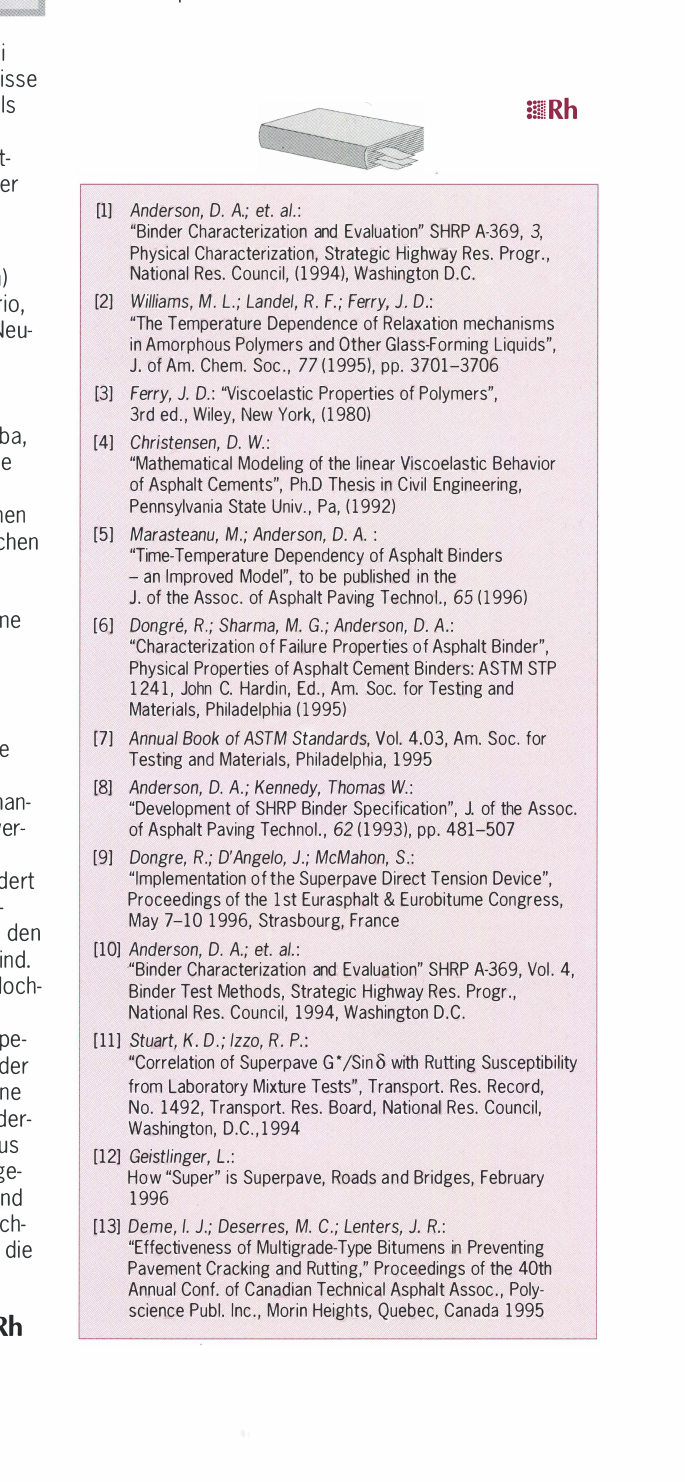
incorporating it into the specification in addition to the creep stiffness and/or m value requirement. At present only strain to failure (from the DT test) is used when creep stiffness is between 300 and 600